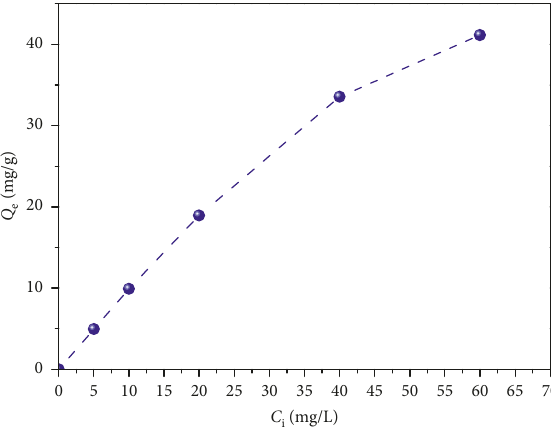
Figure 9: Effect of initial MB concentration on adsorption capacity of dye on geopolymer. Table 6: Adsorption properties according to R R L Information about